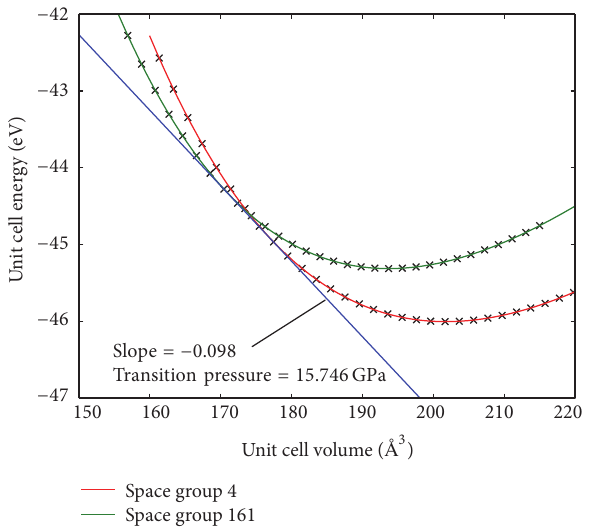
Figure 4: Calculation of transition pressure using the Gibbs construction. Stable space group 4 and space group 161 structures are volumetrically scaled, with their energies calculated using VASP. The slope of the tangent line between the two resulting curves corresponds to the transition pressure between